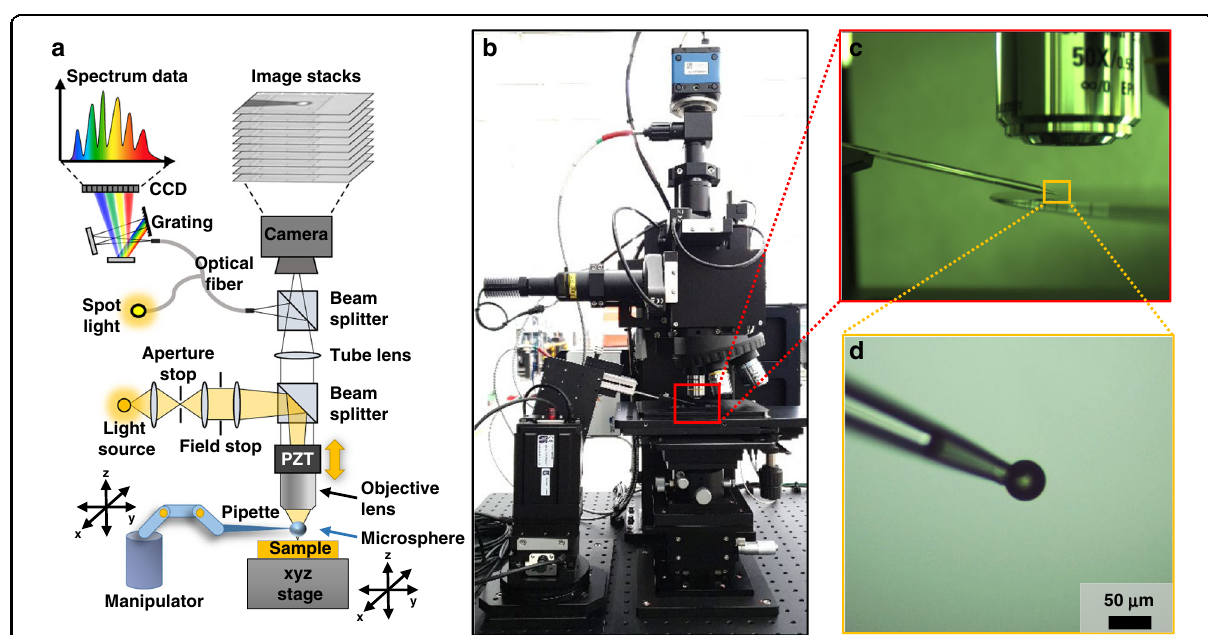
Fig. 1 Con fi guration of the MASR system. a Schematic of the MASR system based on a conventional microscopy con fi guration. A white-light light- emitting diode (LED) was used as the light source, and aperture and fi eld stops were used. The light illuminated the objective lens, microsphere, and sample sequentially. The re fl ected light from the sample was split between the image sensor to capture the image and the grating to analyze the spectrum data. b Imaging optics with the microsphere under the objective lens. c The microsphere attached to the micropipette was controlled by the micromanipulator. d Enlarged image of the microsphere attached to the